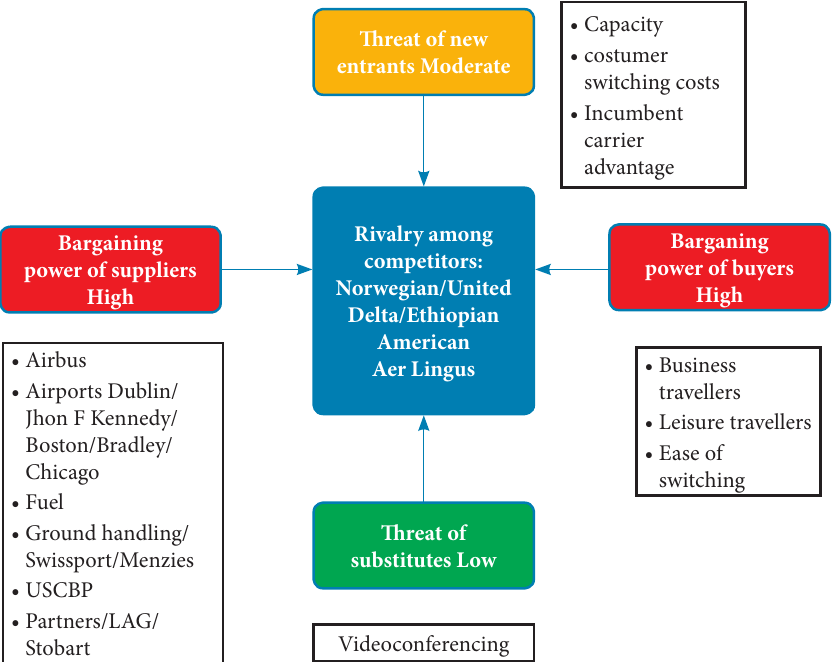
Figure 4. Porter’s five forces for Aer Lingus (Transatlantic market from Dublin